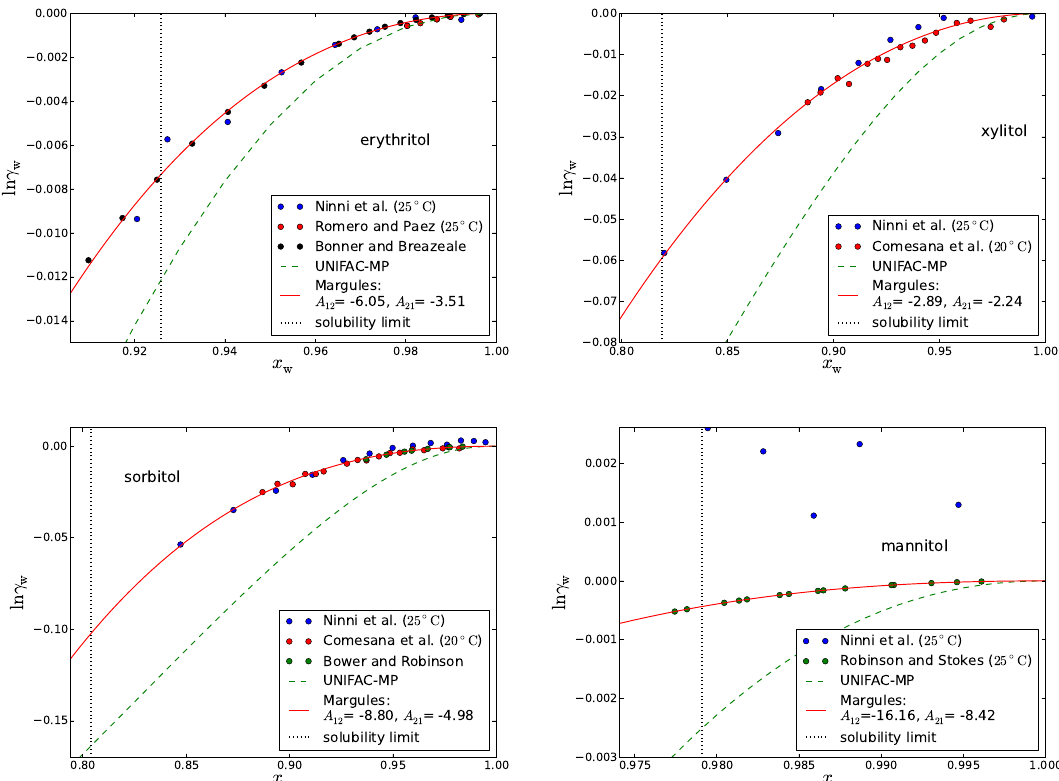
Figure 1. The ln γ w data for erythritol, xylitol, mannitol and sorbitol, compared with the fitting using the Margules formula, and UNIFAC-MP results. Note that the data of Comesaña et al. (2001) are at 20 ◦ C rather than 25 ◦ C, but from their data at 35 ◦ C, it can be deduced that the temperature dependence of ln γ w is small.